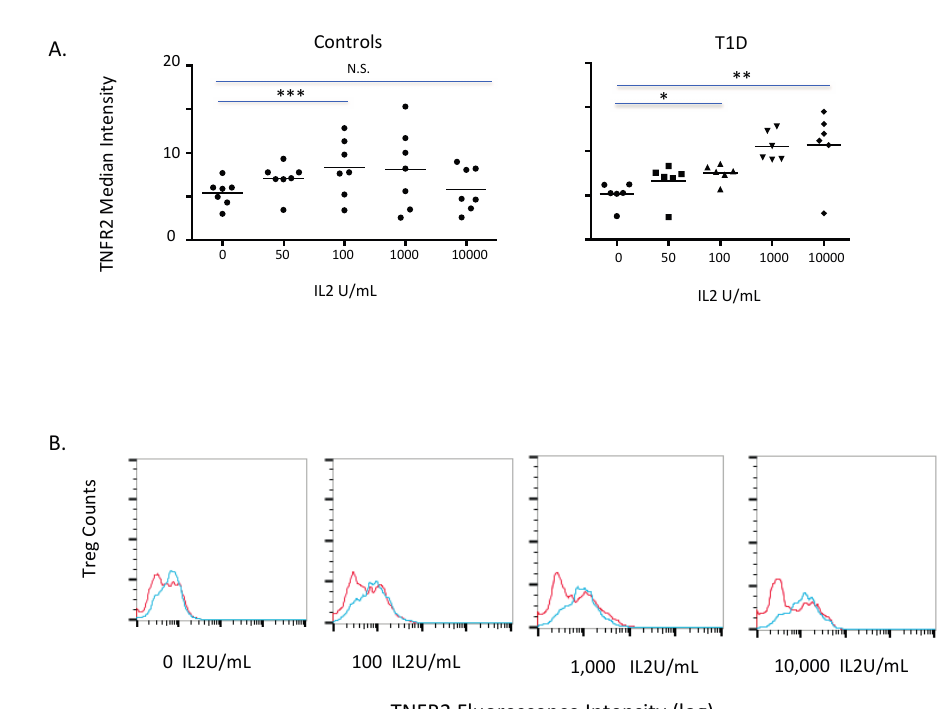
Figure 3. Induction of TNFR2 on Tregs with escalating IL2 exposures in a dose study of 24 h exposures in a comparison of type 1 diabetic (T1D) versus control subject. ( A ) The TNFR2 median fluorescence intensity on isolated Treg; a dose comparison for TNFR2 induction of type 1 diabetic (n = 6) to control (n = 7) subject. For T1D a comparison of no IL2 compared to 100 IL2 U/mL is statistically significant (*, p = 0.01); for a T1D a comparison of no IL2 compared to 10,000 IL2 U/mL is statistically significant (**, p = 0.02). For controls a comparison of no IL2 compared to 100 IL2 U/mL is statistically significant (***, p = 0.02); for controls comparing no IL2 compared to 10,000 IL2 U/mL is not statistically (N.S.)